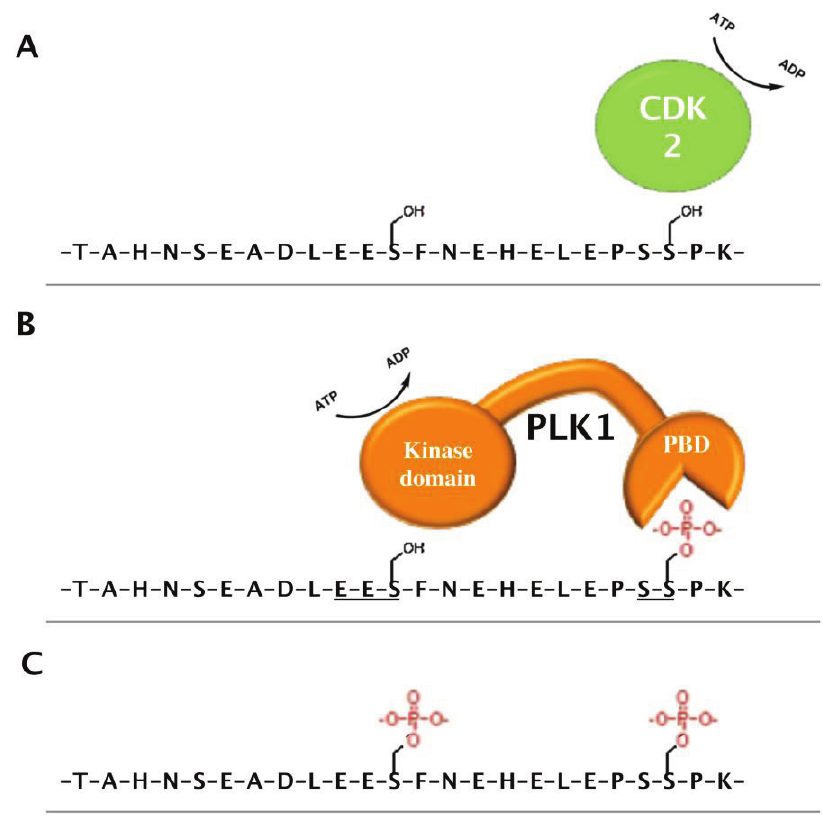
Figure 3. Model for the putative CDK2- and PLK1-dependent phosphorylation of PHF6. Large-scale proteomic studies identified PHF6 Ser-145, -154, and -155 as